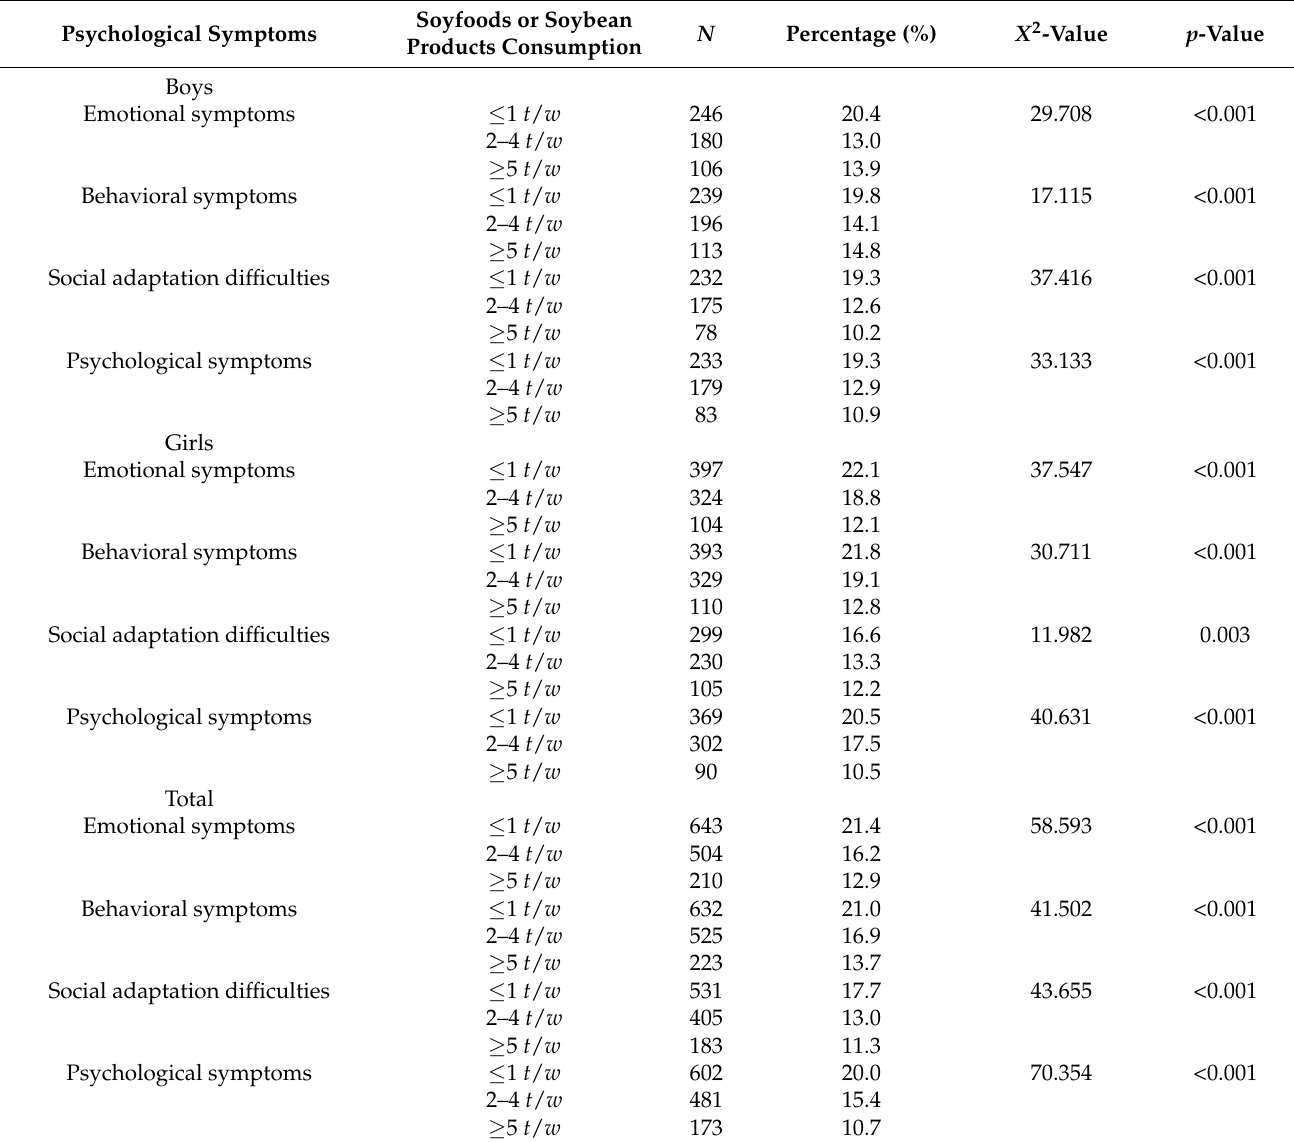
Table 2. Comparison of detection rates of psychological symptoms among university students consuming different soyfoods or soybean products in